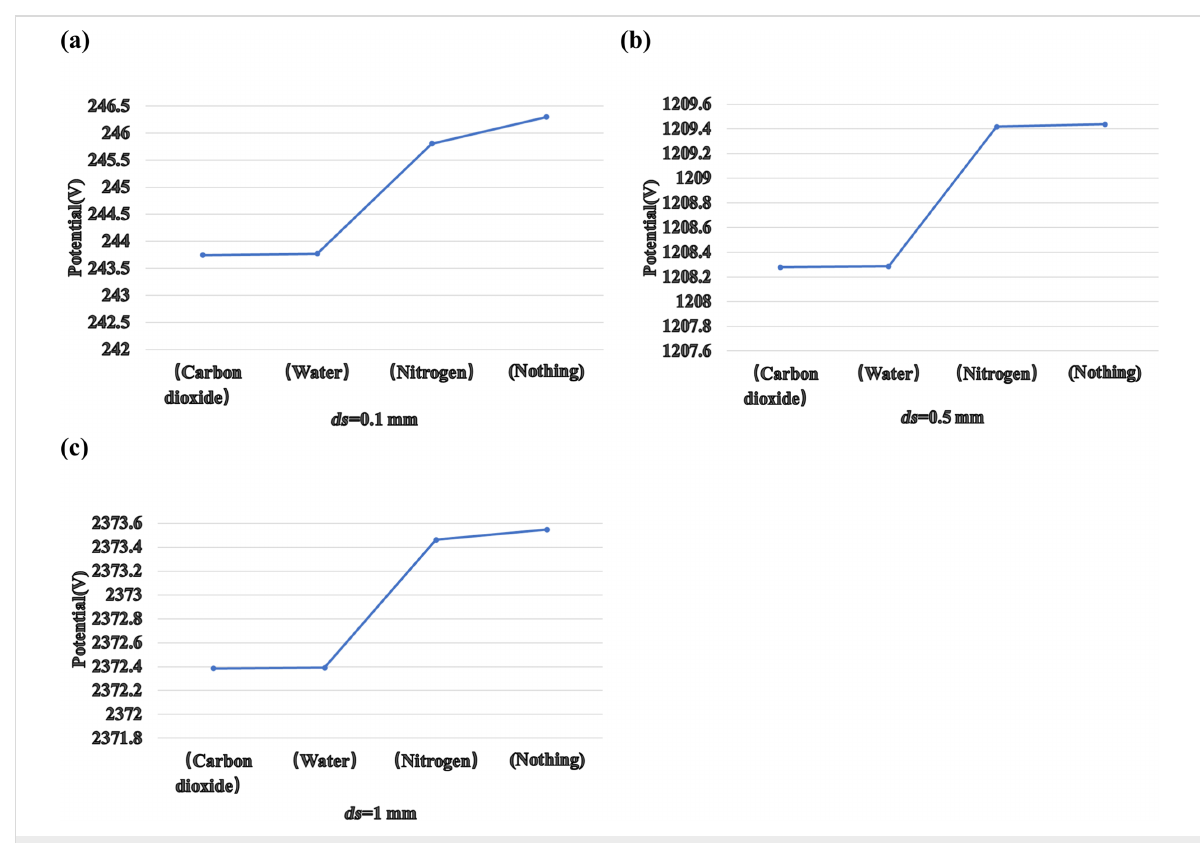
Figure 8: (a) The potential of TENG with different injected gases at (a) ds = 0.1 mm, (b) ds = 0.5 mm, and (c) ds = 1 mm.